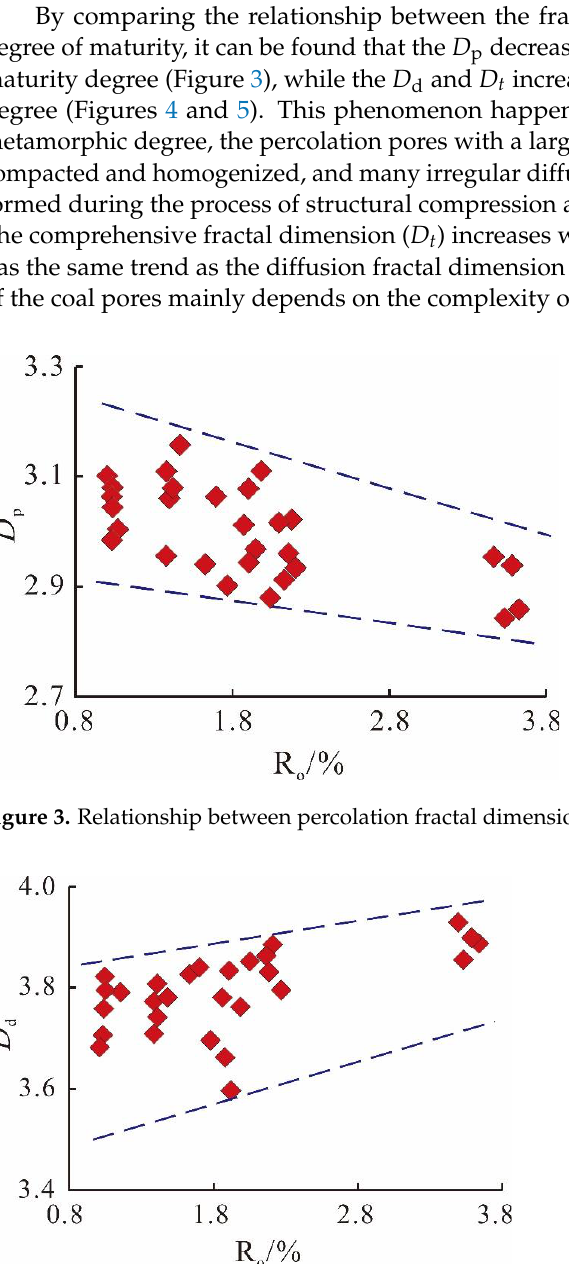
Figure 4. Relationship between diffusion fractal dimension ( D d ) and vitrinite reflectance (R o ).